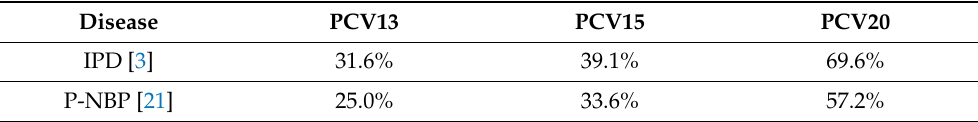
Table 2. Share of cases by